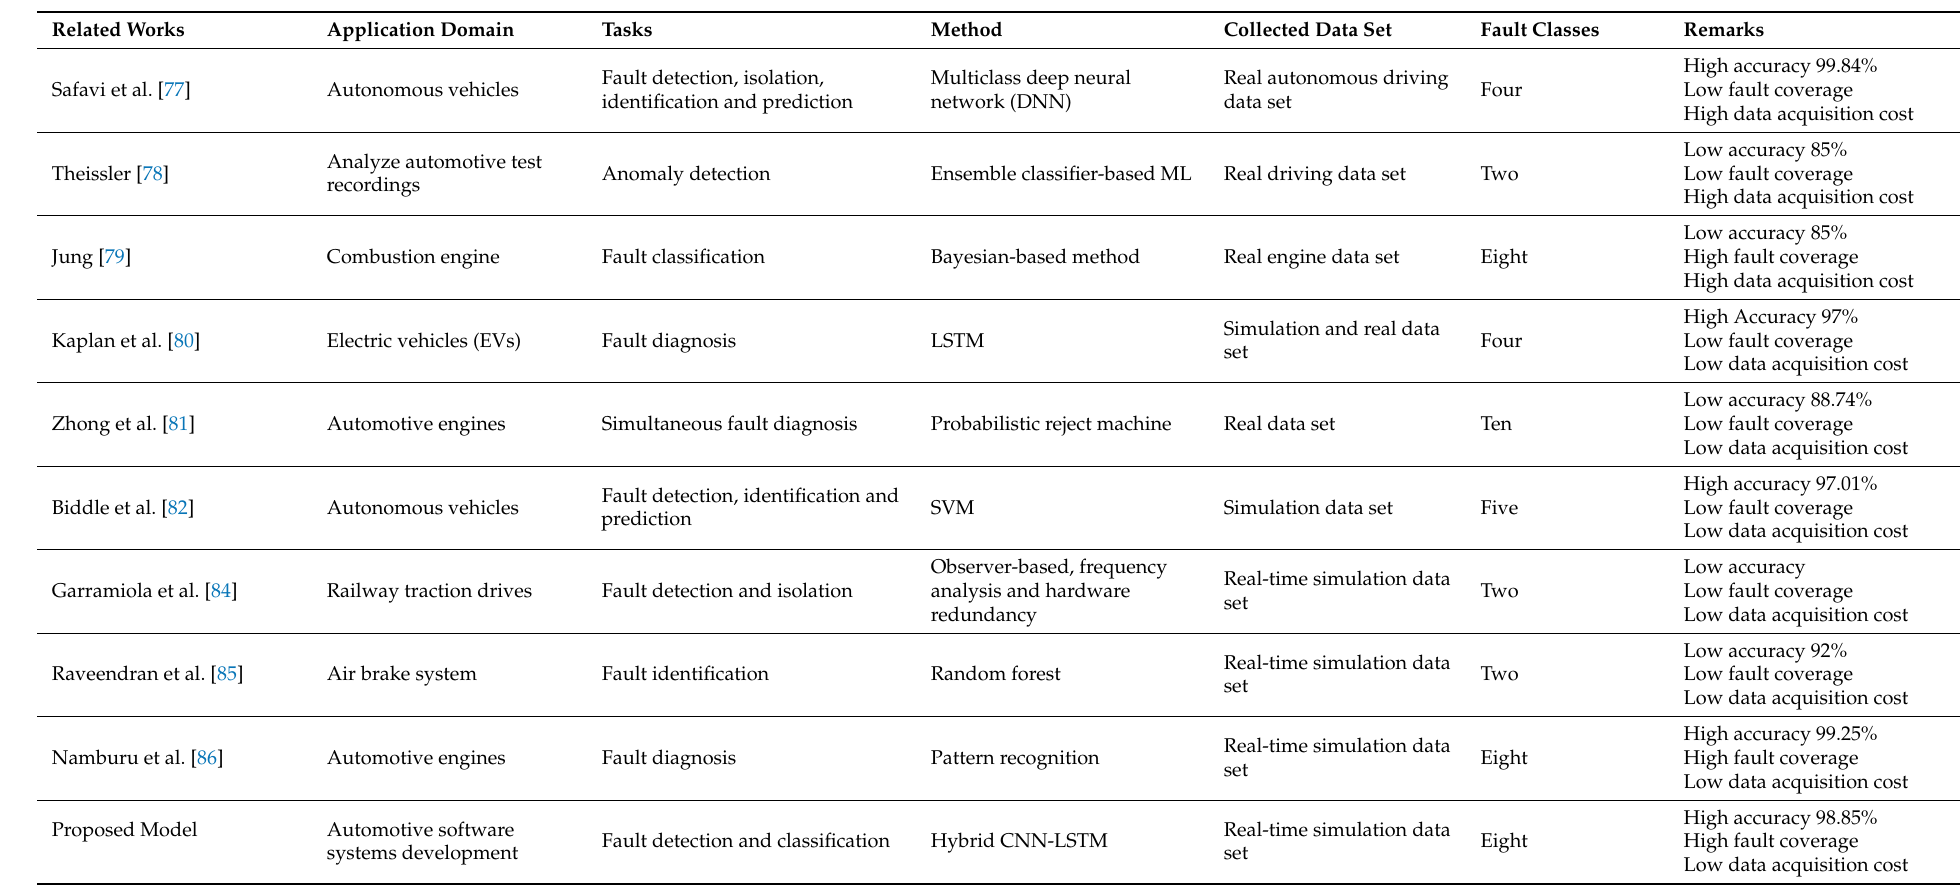
Table 2. Overview of the related